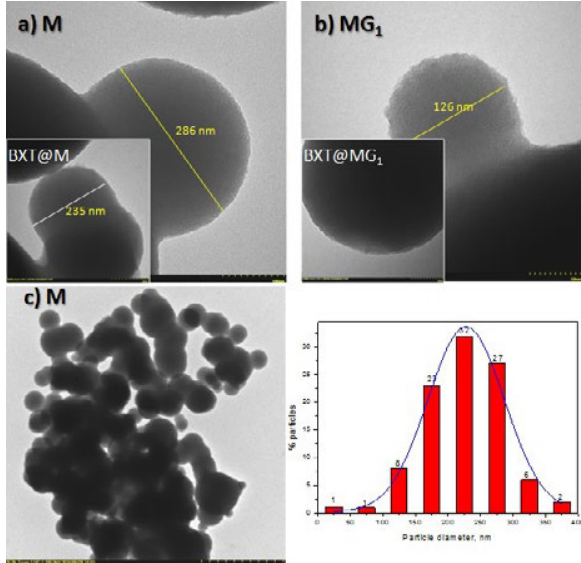
Figure 2. TEM images of: (a) M sample; (b) MG sample (a inset); BXT@MG